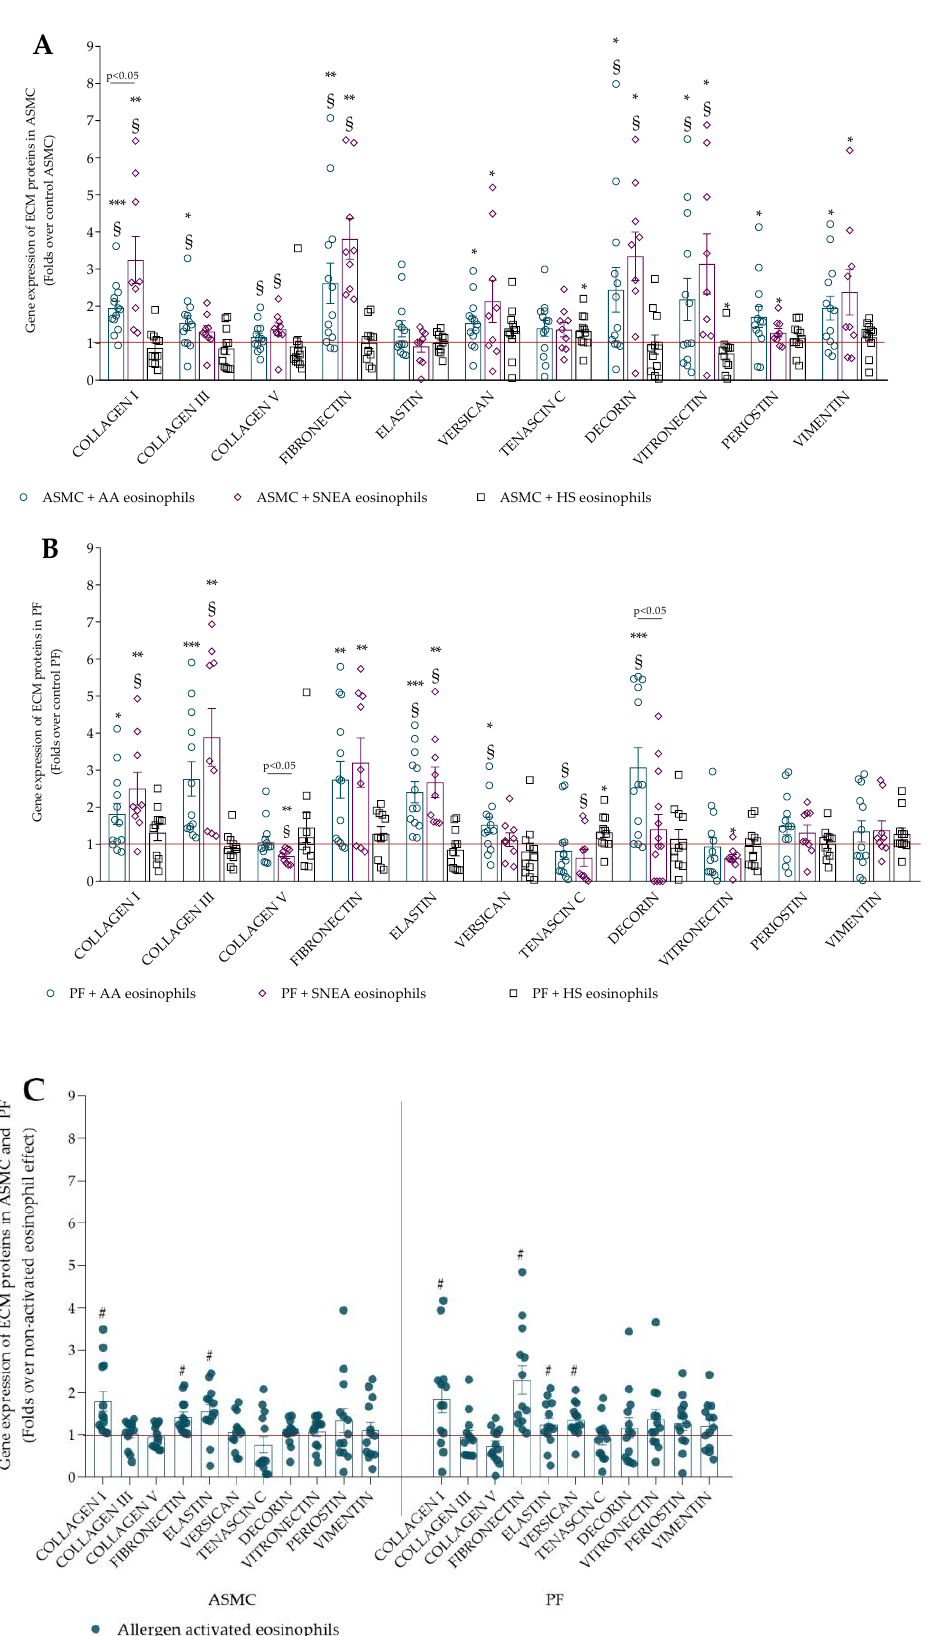
Figure 1. ( A )—Gene expression of ECM proteins in ASMC; ( B )—gene expression of ECM proteins in PF; ( C )—gene expression of ECM proteins in ASMC and PF after incubation with allergen-activated eosinophils. Data presented as mean ± SEM, fold change over control ASMC or PF, and fold change over eosinophil effect before bronchial allergen challenge. AA—allergic asthma; ASMC—airway